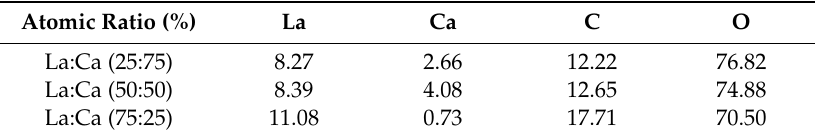
Table 1. Atomic ratios in three samples using XPS